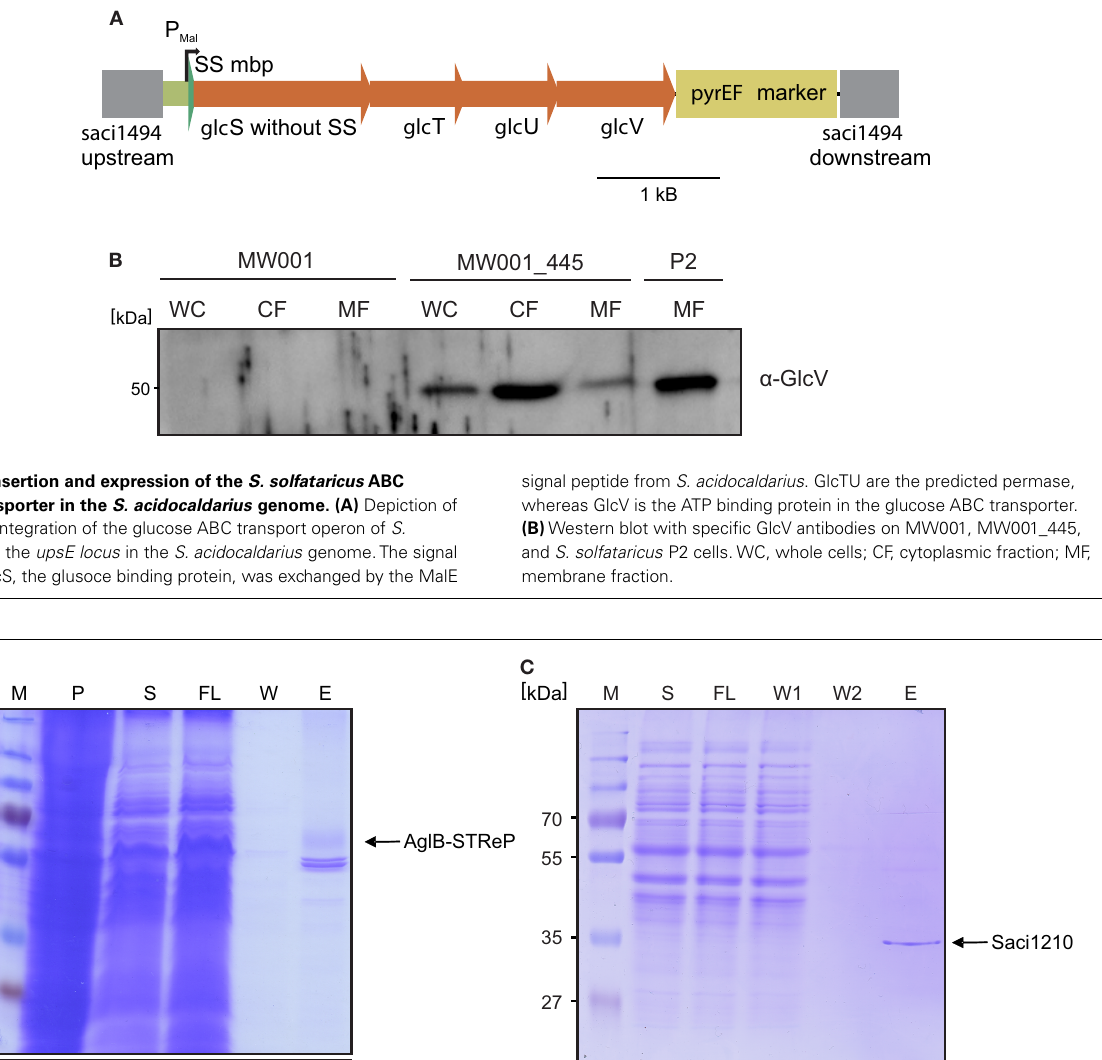
SDS-PAGE and an immune blot with a-His-tag antibodies (D) of the purification of Saci1210 which was genomically tagged using His_SELECT material. M, marker; P, insoluble membrane pellet; S, solubilized membrane proteins; FL, flow through;W, wash fraction; E, elution fraction.